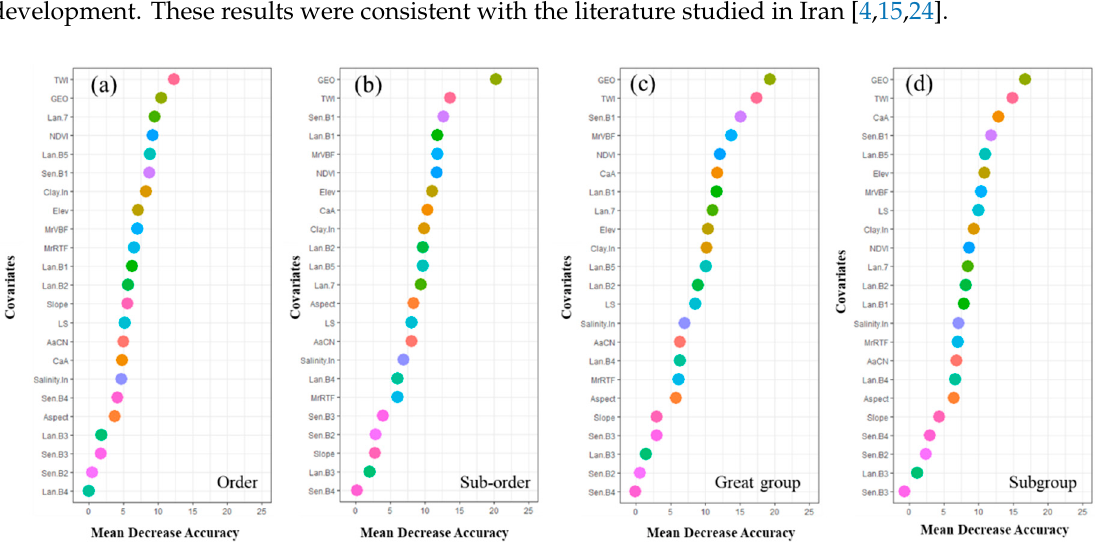
Figure 3. The importance of variables used for predicting soil classes in four taxonomic levels: Order ( a ), Sub-order ( b ), Great group ( c ) and Subgroup ( d ). Codes refer to Table 2.